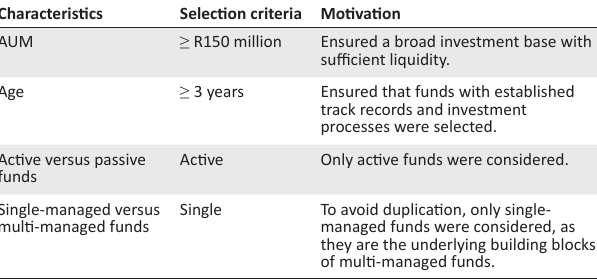
TABLE 2: Sample selection